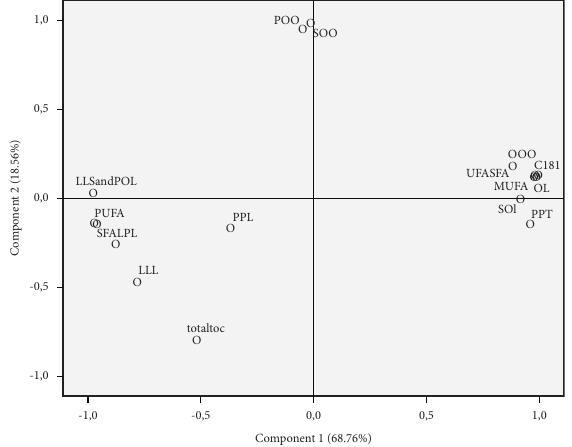
Figure 1: Projection of almond oil composition in the plane de- fined by the first two principal components.